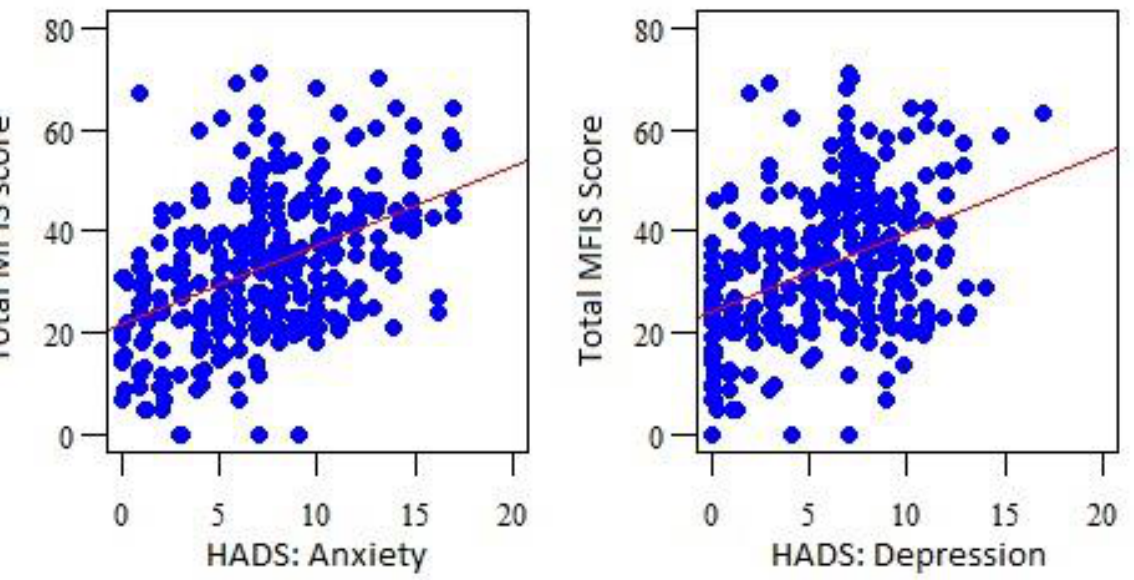
Figure 1. MFIS and HADS correlations. MFIS—Modified Fatigue Impact Scale. HADS—Hospital Anxiety and Depression Scale. Table 5. Correlations between the MFIS and HADS scores.